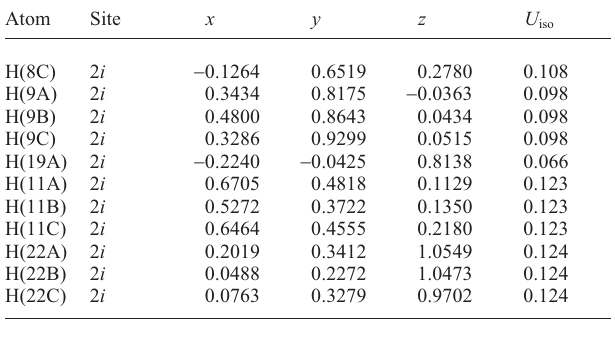
Table 2. Atomic coordinates and displacement parameters (in Å 2 )